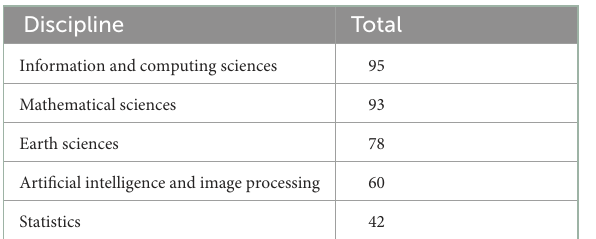
TABLE 4 Top discipline covered by spatio-temporal product-sum